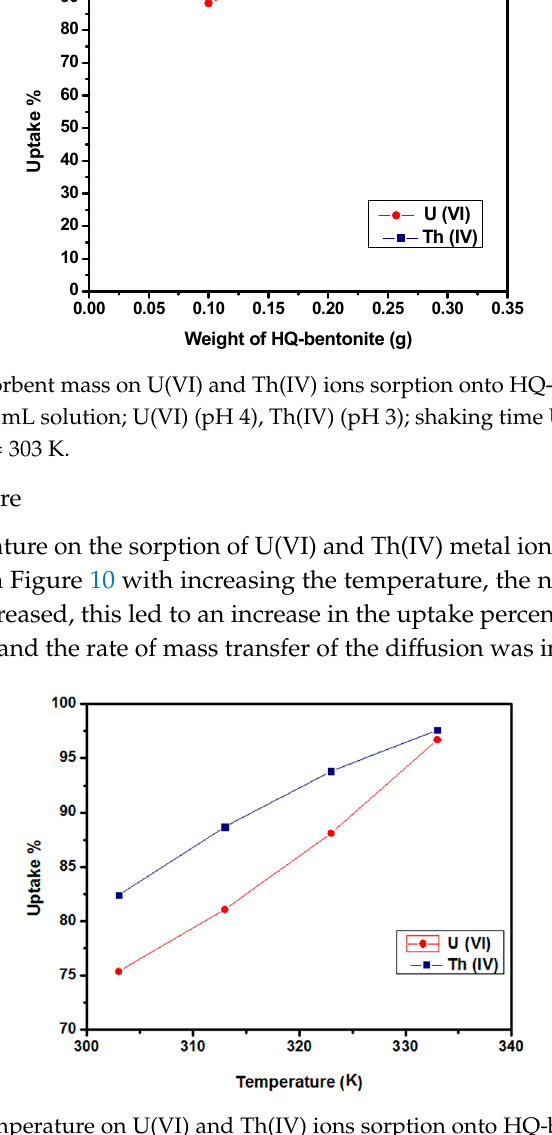
Figure 10. Effect of temperature on U(VI) and Th(IV) ions sorption onto HQ-bentonite. Conditions: